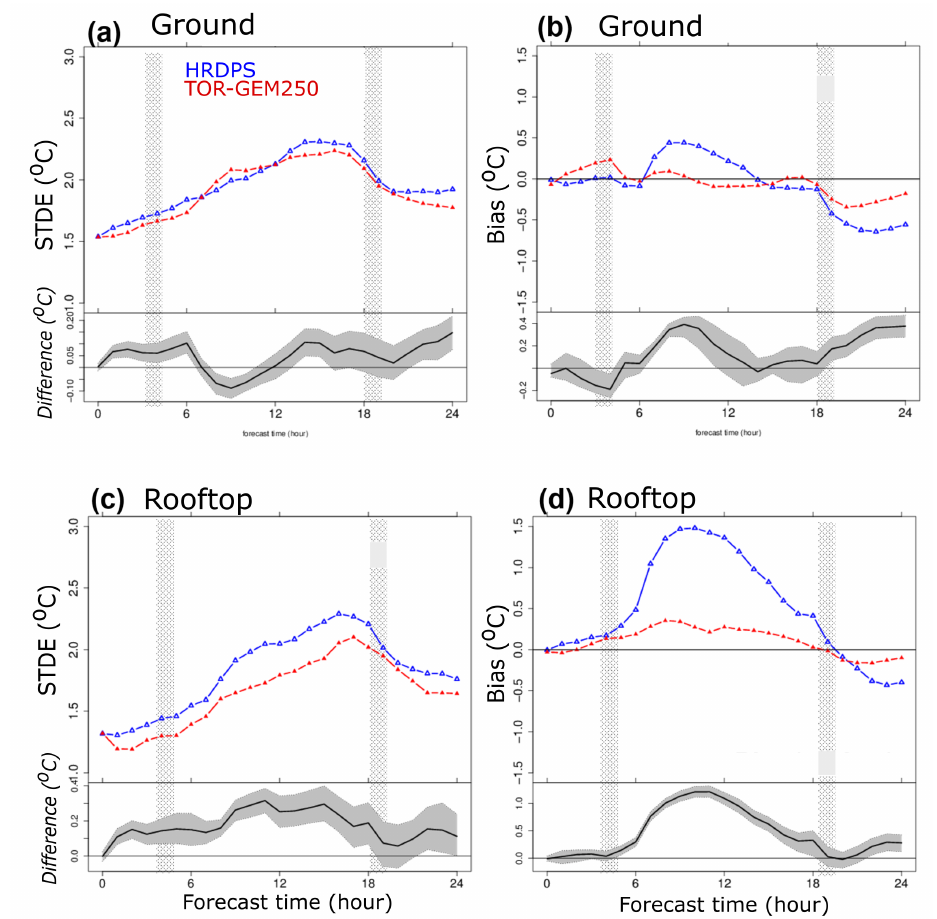
Figure 14. Same as Figure 12 but for the dew-point temperature. ( a ) STDE and ( b ) Bias for the ground stations, ( c ) STDE and ( d ) Bias for the rooftop